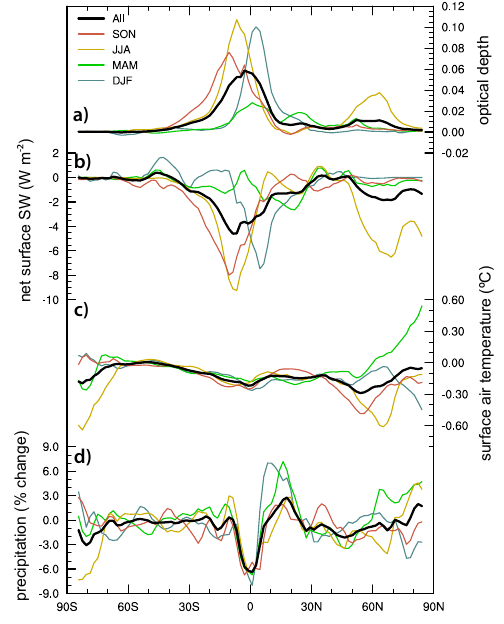
Fig. 6. Global maps of climate anomalies (FIRE minus NOFIRE for (b–d) only) from CAM5 simulations: (a) top-of-atmosphere ra- diative forcing (W m − 2 from FIRE run only), (b) net insolation (W m − 2 ), (c) surface air temperature ( ◦ C), and (d) precipitation (mm d − 1 ). Dotted stippling of statistical significance (95%). Sig- nificance was determined by computing the t test statistic at each grid cell for α = 0 . 05. Surface air temperature was the mean mid- layer air temperature in the lowest atmospheric level of the